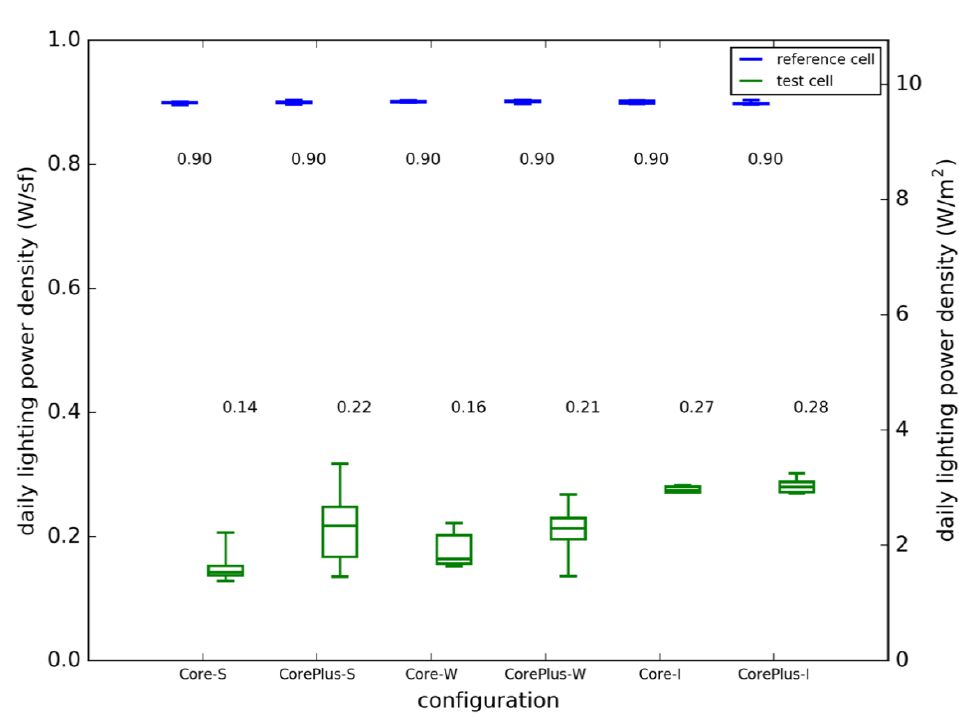
12 of 23 Figure 6. Daily lighting energy savings (%) for each configuration over the test period. Figure 7 shows the average lighting power density (LPD) over occupied hours for the reference and test cases for each configuration. The reference case (which has no daylighting or occupancy controls) is constant at 9.7 W/sq.m (0.9 W/sf). The test case median LPD for interior configurations—